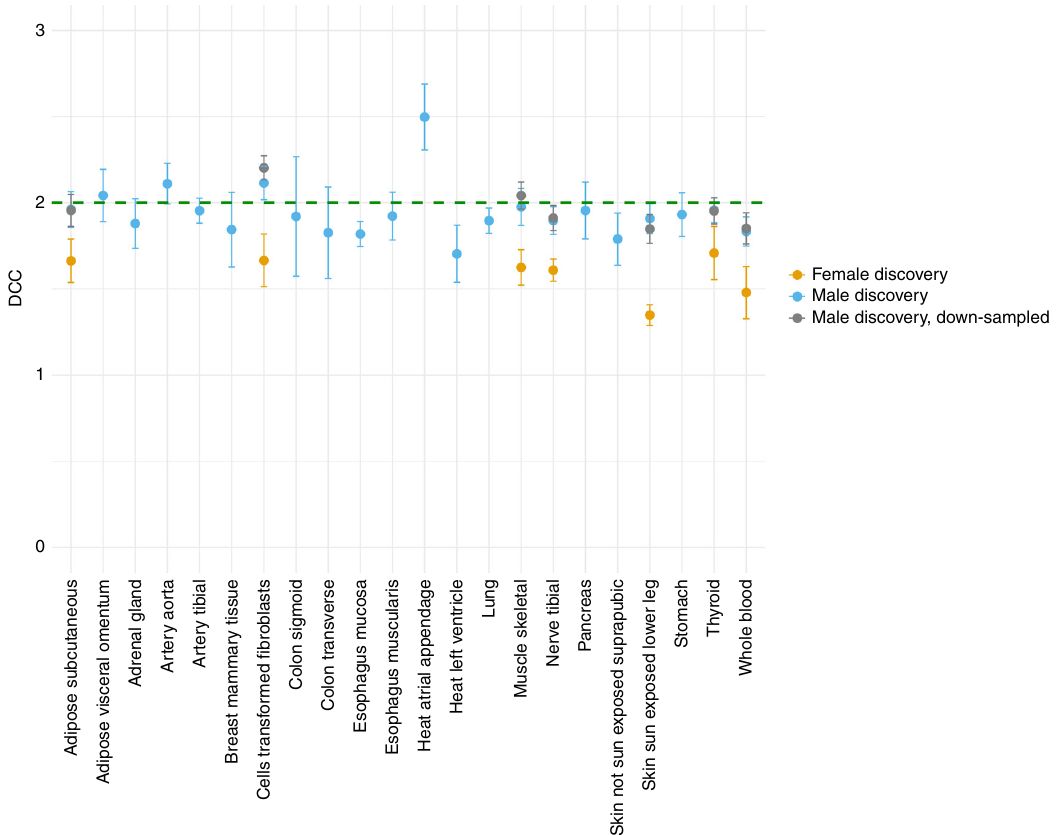
Fig. 4 Dosage compensation coef fi cient (DCC) for eQTLs across tissues. DCC is estimated for tissues with at least three eQTLs that satis fi ed the within tissue Bonferroni signi fi cance threshold in each of the 22 tissue-types. A mean of 28 (SD = 18) eQTL are identi fi ed in the male discovery analysis giving a mean DCC of 1.94 (SD = 0.16) across 22 tissues. A mean of 5 (SD = 0.82) eQTLs are identi fi ed in the female discovery analysis giving mean DCC of 1.59 (SD = 0.13) across seven tissues. The coloured bars represent the standard errors. Males were down-sampled 100 times so that the proportions match that of females within each of the seven tissues, and mean DCC is calculated across the 100 replicates. The grey bars represent the standard deviation across 100 replicates. SD, standard